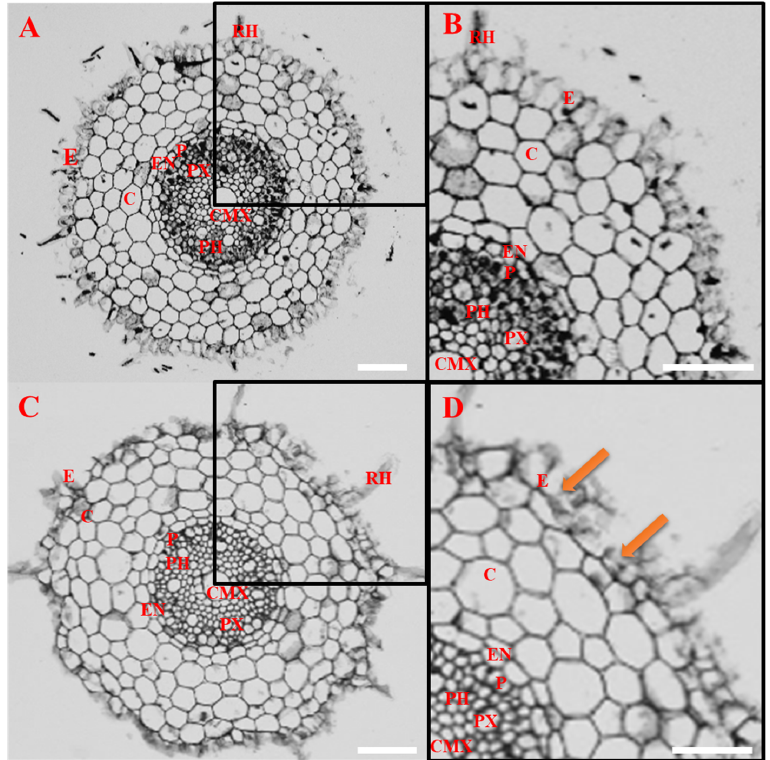
Figure 2. Histological observations of B. distachyon root cross-sections in the control ( A , B ) and after 72 h of treatment with 750 µM 3,4-DHP ( C , D ). Abbreviations: C—cortex, CMX—central metaxylem, E—epidermis, EN—endodermis, P—pericycle, PH—phloem, RH—root hair, and PX—protoxylem. Orange arrows indicate ruptured cells. Scale bars: 50 µm.